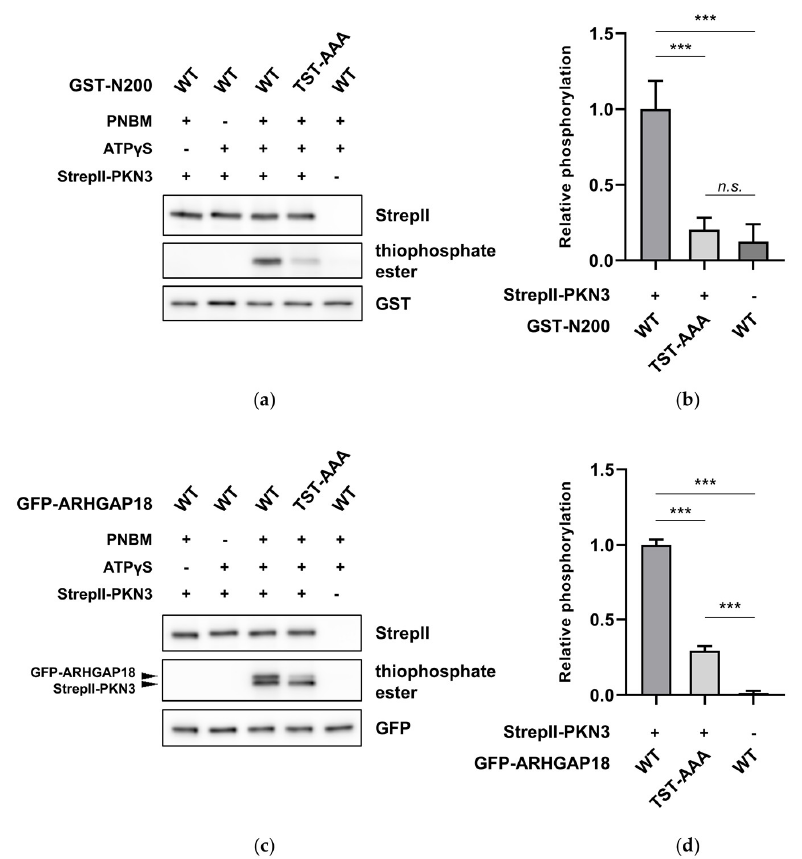
Figure 2. PKN3 phosphorylates ARHGAP18 (Rho GTPase Activating Protein 18) on Thr154, Ser156 and Thr158. An in vitro kinase reaction of WT and unphosphorylatable TST-AAA (Thr154, Ser156 and Thr158 to alanine) variants of ( a ) GST-fused fragment of ARHGAP18 comprising the first 200 amino acids or ( c ) the full-length GFP-ARHGAP18 (upper band; lower band corresponds to StrepII-PKN3 autophosphorylation) in the presence of StrepII-PKN3 and ATP γ S. Thiophosphorylated substrates were treated with PNBM and immunoblotted using anti-thiophosphate ester antibody. Reactions with ATP γ S or PNBM only were used as specificity controls. Quantification of relative phosphorylation from three independent experiments is shown for both ( b ) GST-N200 and ( d ) full-length GFP-ARHGAP18 variants. Statistical analysis was performed using ANOVA with Tukey′s multiple comparison test: *** p ≤ 0.001, n.s. – not significant.